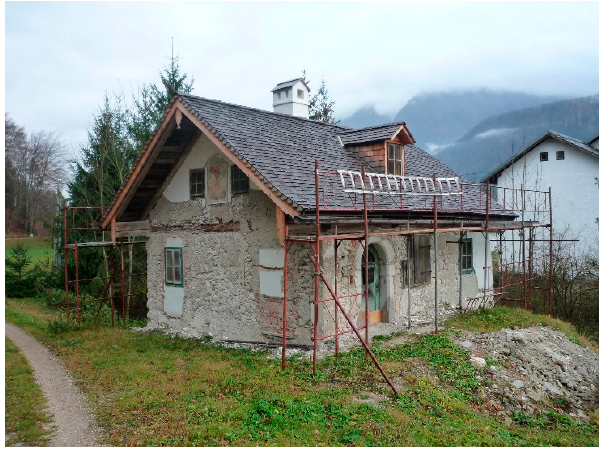
Figure 1. Building object on which measurements were conducted.